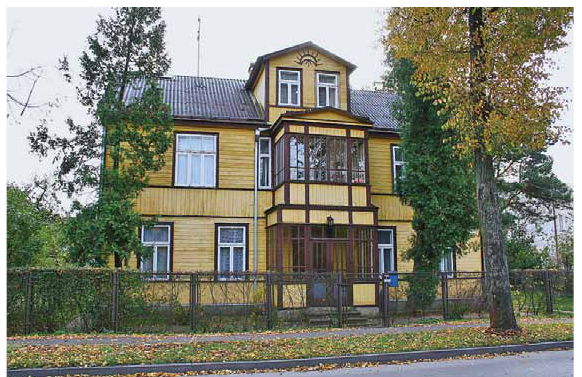
fig. 9. Well survived wooden house at Panemune, Smetonos av. 81